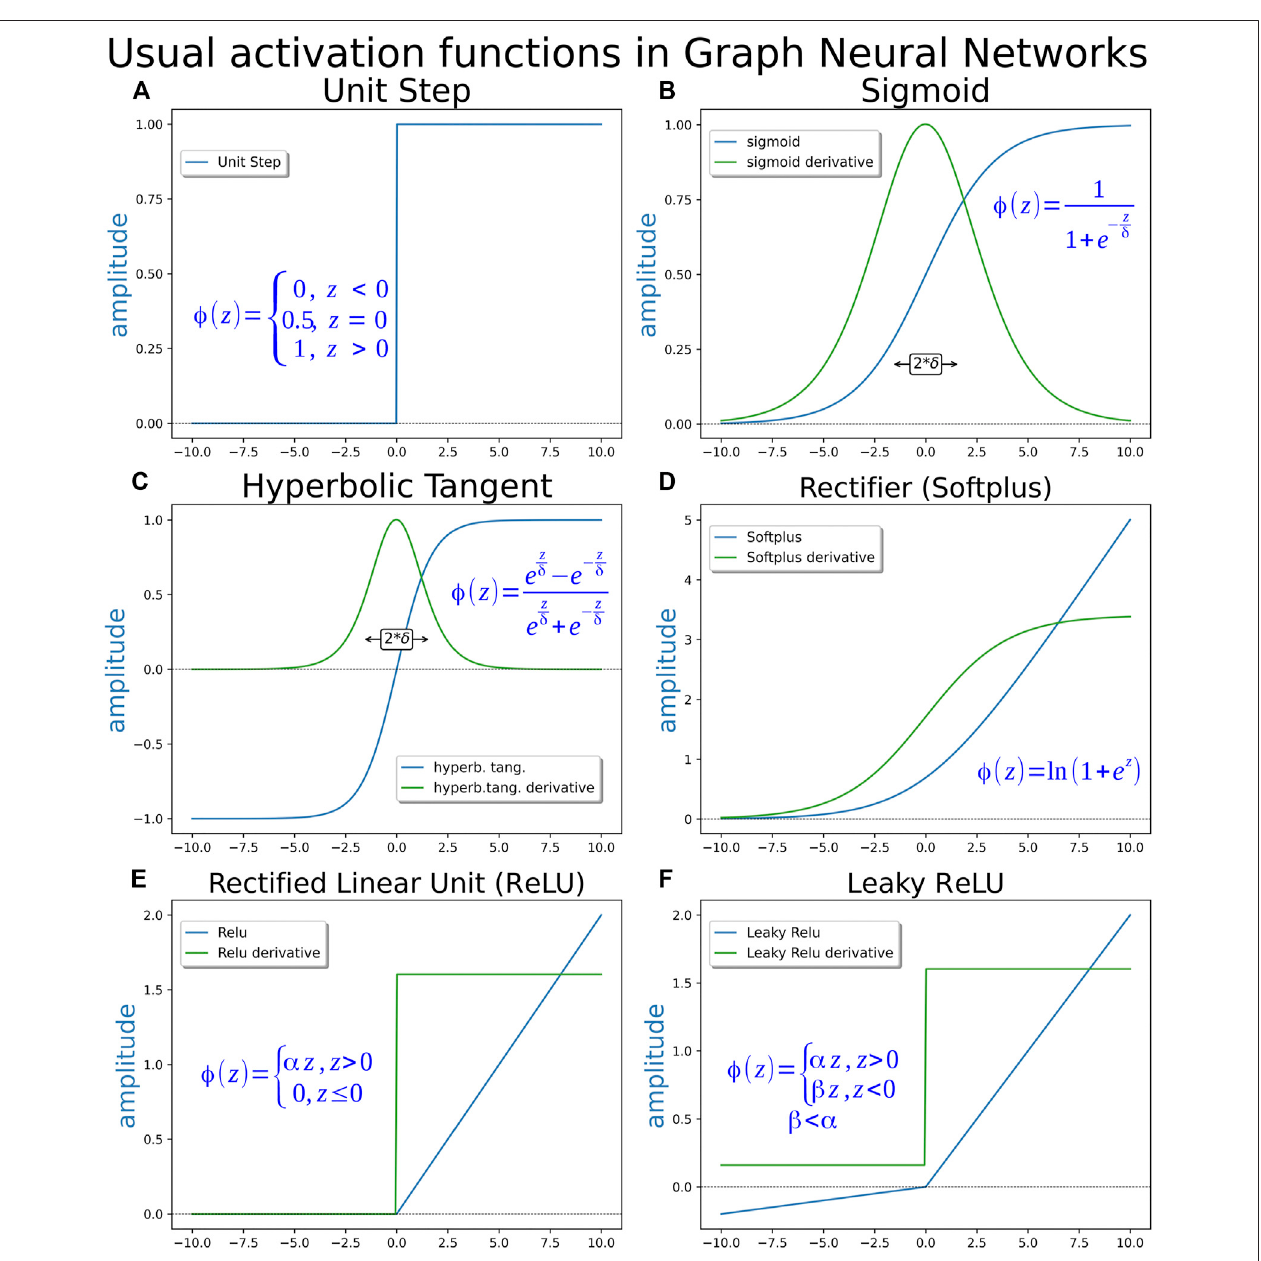
FIGURE4| Activationfunctions. (A) Unitystepfunction,binarystepfunctionorheavisidefunction – Thisfunctionwasusedintheearlyperceptronera.Itisunsuitable for gradient descent learning methods, since its derivative is 0 along almost the entire domain. (B) Logistic or sigmoid function — This is perhaps the most extensively applied activationfunction.Itsanswermaybecomesteep,dependingonthevalueofparameter δ . (C) Hyperbolictangent(TanH) — Thisfunctionisusedasanalternative tothesigmoidfunctionwhenarangeofoutputfrom − 1to1isneeded,insteadoftherangefrom0to1givenbythesigmoidfunction. (D) Softplusfunctionorrecti fi er (as the shape of the function resembles the behavior of a recti fi er diode) — It is differentiable along the entire domain as the two previous functions, but displays an advantage, since its derivative exhibits non-zero values along the entire positive domain while sigmoid and hyperbolic tangent present derivatives approaching zero asymptotically for large argument values. A non-zero derivative along a broader range may contribute to speed up the learning process. The derivative of the softplus function is the sigmoid function. (E) Recti fi ed linear unity function (ReLU) — This function is used as a simple linear alternative to the softplus, maintaining the same advantage of a non-zero derivative along the entire positive domain but suffering the problem of a discontinuity in the derivative for argument equal to 0. (F) Leaky ReLU — This function is a “ leaky ” form of ReLU. The answer of this function in the negative domain comprises an attenuated version of the linear response in positive domain,insteadof0.Dependingon theattenuation parameterbeingaconstantoranadjustablevalue, thefunction maybe alsonamed ParametricReLU. Thenon-zero negative domain provides some decrease in the occurrence of dead neurons, the region of ReLU curve where any signal corresponds to zero as a response, in the